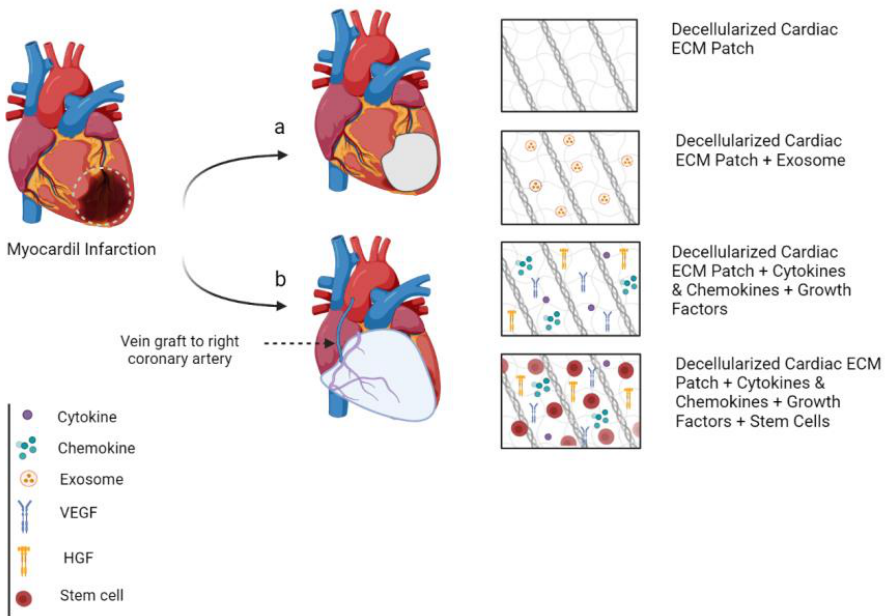
Figure 2. The interplay between decellularized cECM patch, growth factors, and further seeding of stem cells; ( a ) small patch, which cells will die because they do not have access to vascular network when they are implanted, ( b ) large-scale cardiac patch.